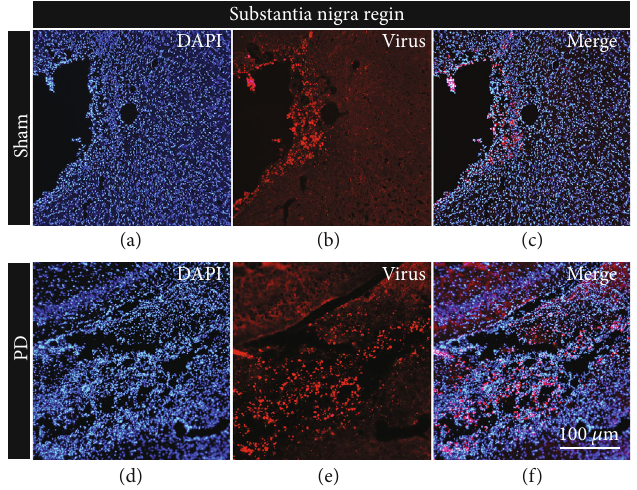
Figure 7: Viral expressed. (a – c) The pictures are the coronal sections of the substantia nigra compact part (AP: − 5mm, ML: 2 mm, and DV: 7.9mm) of the control group rat under di ff erent conditions (DAPI, TH, and merge). (d – f) The pictures are the coronal sections of the SNC part (AP: − 5mm, ML: 2mm, and DV: 7.9 mm) of the experimental group rat under di ff erent conditions (DAPI, TH, and merge). Scale bar 100 μ